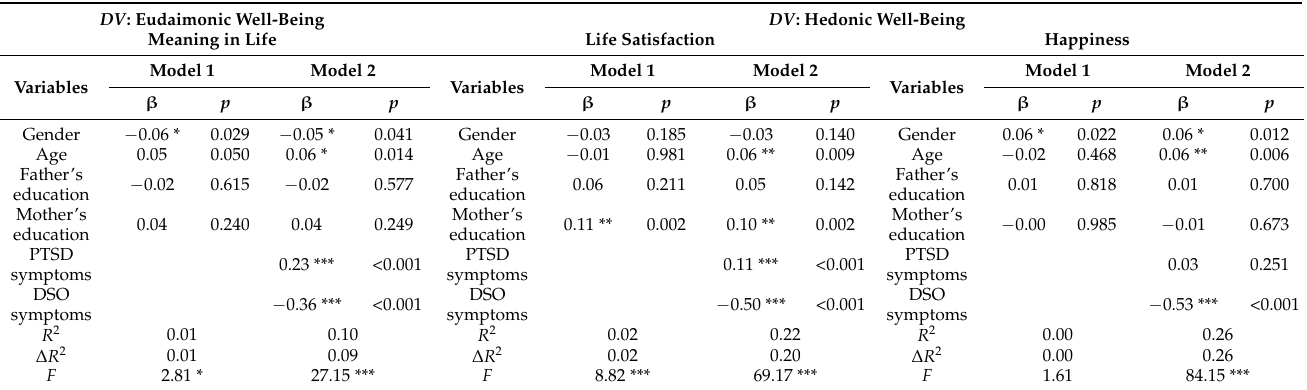
Table 4. Hierarchical linear regression analysis results for PTSD symptoms and DSO symptoms predicting hedonic and eudaimonic well-being ( n = 1451).